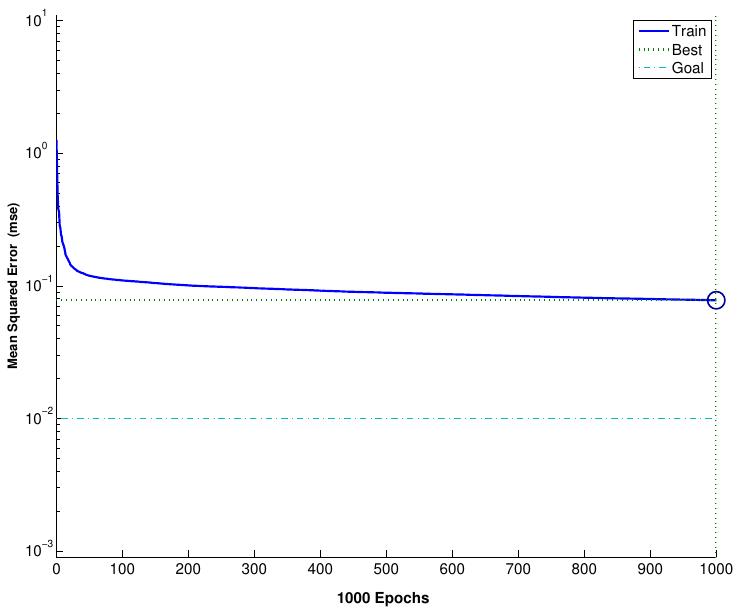
Figure 5. Training performance of the proposed ANN